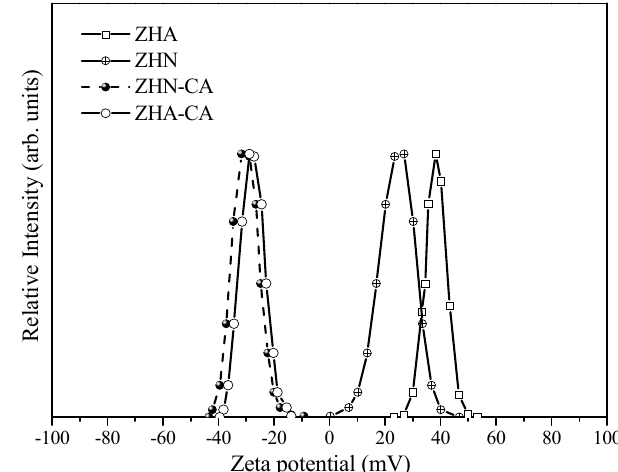
Figure 1. Zeta potential distribution of ZHN, ZHA, ZHN–CA, and ZHA–CA materials.